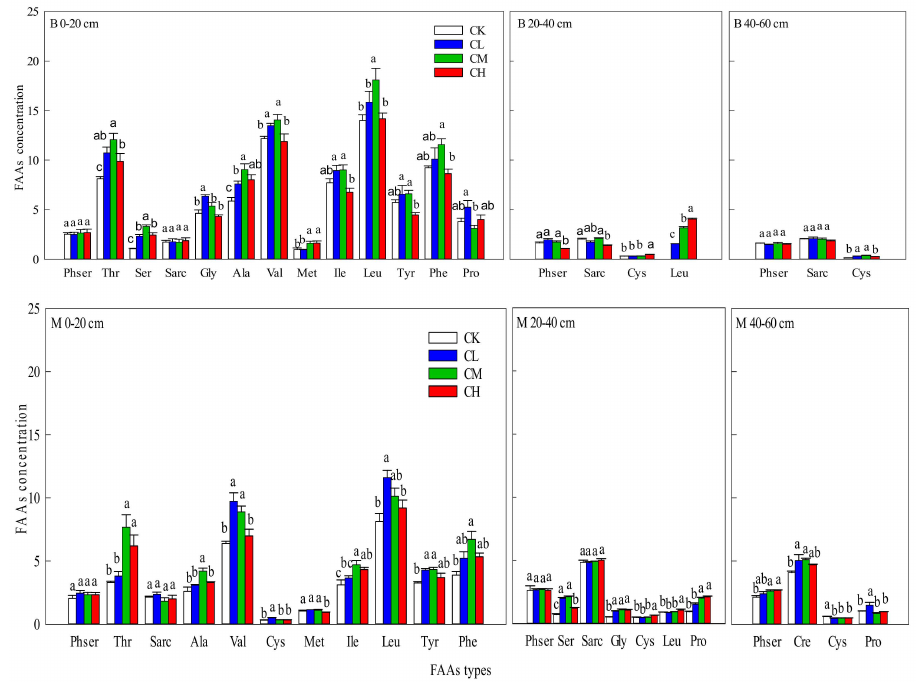
Figure 4. FAAs Profile distribution of different fertilization treatments in the rice growth stage. CK: chemical fertilizer, CL: the low amount of CMV, CM: the medium amount of CMV, CH: the high amount of CMV, Note: B: background soil, M: maturity stage. The error line indicates a standard error (n = 3). Lowercase letters represent significant differences between treatments ( p < 0.05, Duncan